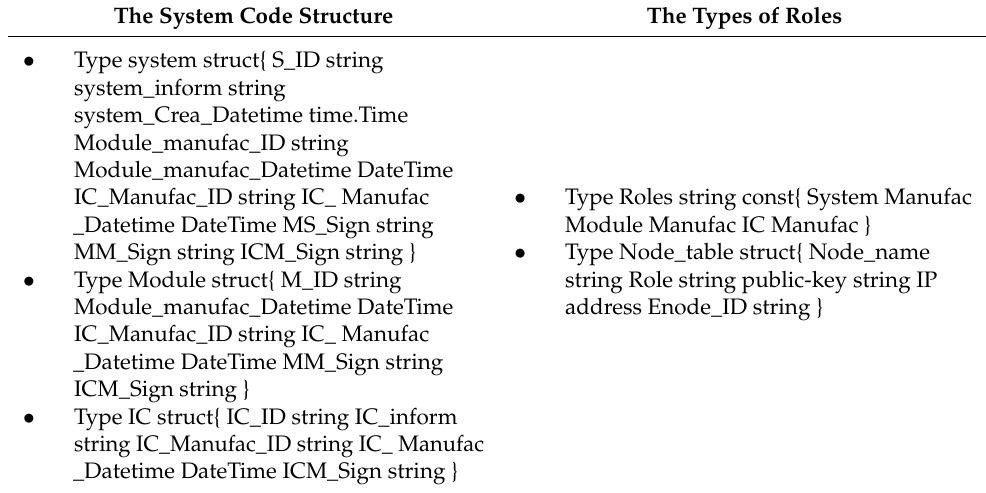
Table 2. The code structure of smart